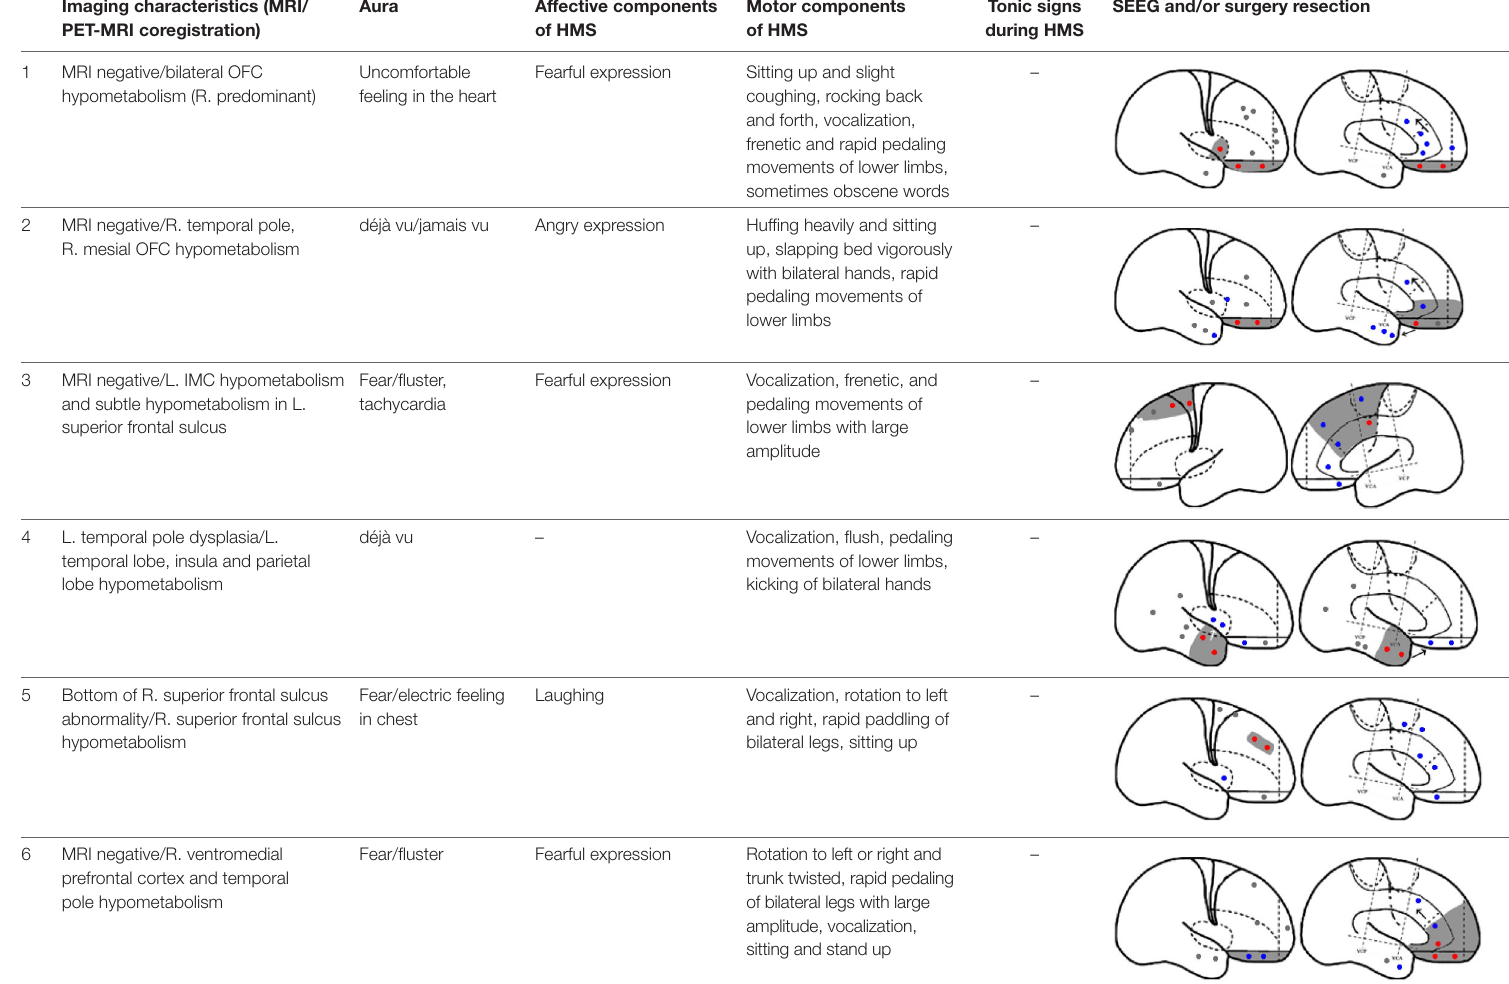
Table 1 | Seizure semiology and surgery resection in patients with HMS1. imaging characteristics (Mri/ PeT-Mri coregistration) MRI negative/bilateral OFC hypometabolism (R. predominant)